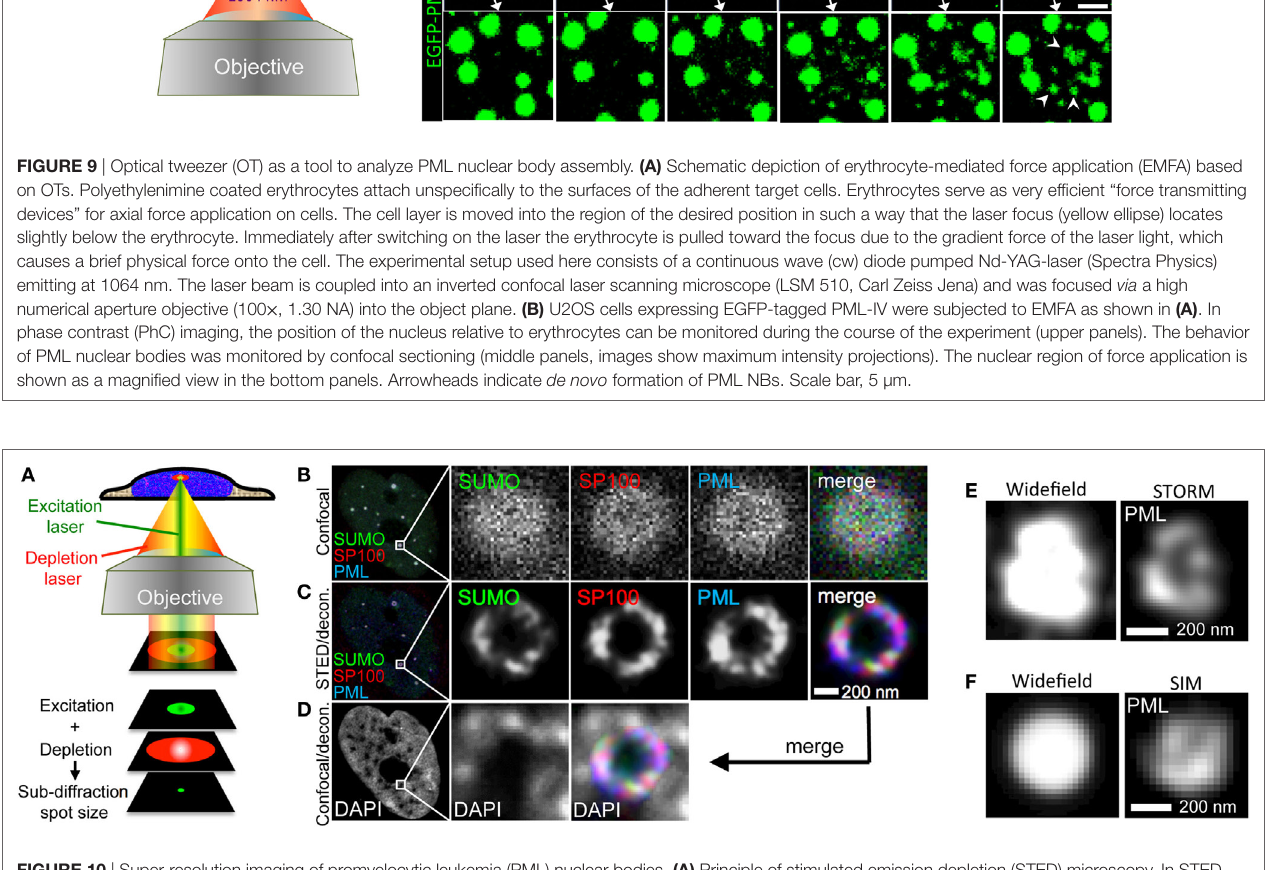
FigURe 10 | Super-resolution imaging of promyelocytic leukemia (PML) nuclear bodies. (A) Principle of stimulated emission depletion (STED) microscopy. In STED, two lasers are focused through a high numerical aperture objective lens. The excitation laser (green) serves to excite the fluorophore of interest similar to confocal imaging. Excitation light pulses are immediately followed by a high energy red-shifted STED beam with circularly polarized light (red). The STED light de-excites the excited fluorescence except for a small central spot due to the donut-like shape of the STED beam. This results in a subdiffraction size illumination excitation beam which can be scanned across the sample with a confocal scanner to produce super-resolved images. (B–D) Example of 3-color STED imaging of PML NBs using a Leica STED microscope. Fixed U2OS cells were immunofluorescently labeled to detect SUMO, SP100, and PML with secondary antibodies coupled to STAR-635P (green), STAR-580 (red), and Atto-490LS (blue), respectively. All dyes were depleted using the 770 nm STED laser. (B) shows one confocal section in the center of the nucleus recorded in confocal mode. (C) shows the same focal section as in (B) but recorded with the depletion laser switched on followed by deconvolution of the fluorescence signals using Huygens software (STED/decon.). (D) The DAPI signal was also acquired in the same focal section employing the HyVolution II mode of the Leica LSM ( = confocal mode with the pinhole closed to 0.5 Airy units followed by deconvolution) (Confocal/decon.). (e) 3D-STORM imaging of a PML nuclear body in U2OS cells immunofluorescently labeled with an anti-PML antibody (Secondary antibody: Alexa-647N). (F) Super-resolution SIM imaging of a PML nuclear body in U2OS cells immunofluorescently labeled with an anti-PML antibody (Secondary antibody: Cy3). STORM and SIM imaging was performed using a Zeiss Elyra system.